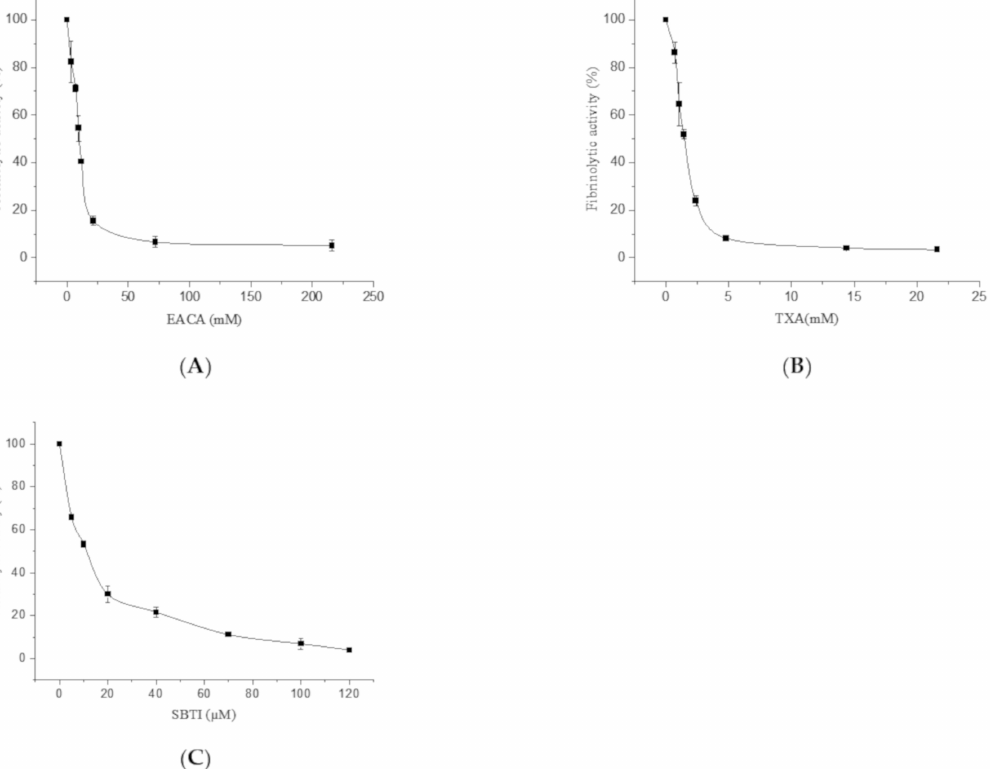
Figure 5. The fibrinolytic activity of FGFC1 at different concentrations of EACA (0–216 mM) ( A ), TXA (0–21.6 mM) ( B ), and SBTI (0–120 µ M) ( C ). The reaction was incubated at 37 ◦ C and measured at 405 nm using a microplate reader every five minutes for 120 min. Results are expressed as a percentage of the fibrinolytic activity in the absence of EACA, TXA, and SBTI. The results are expressed as the mean ± SD, performed in triplicate. The concentration of FGFC1 for the FGFC1 + EACA, FGFC1 + TXA, and FGFC1 + SBTI assays was 0.12